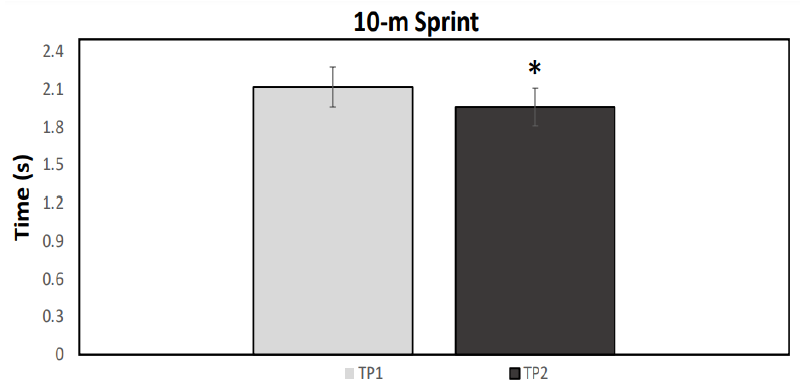
Figure 3. Mean values for the 10-m linear sprint performance during the two testing points (TP1 and TP2). * Statistically significant difference ( p < 0.05).